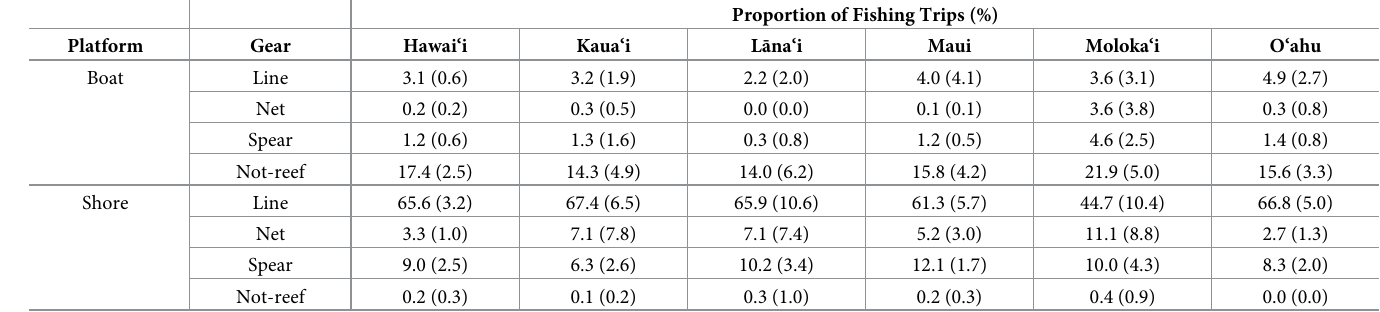
Table 2. Recreational trip types. Data come from MRIP telephone surveys in 2004–2013. Data are summarized as mean and standard deviation per island and wave of the percentages of fishing trips per combination of platform (boat or shore) and gear as defined by Eq 2. Gears have been pooled into line, net, spear, or not-reef (offshore, pelagic or bottomfish fishing), as described in S2 Table.